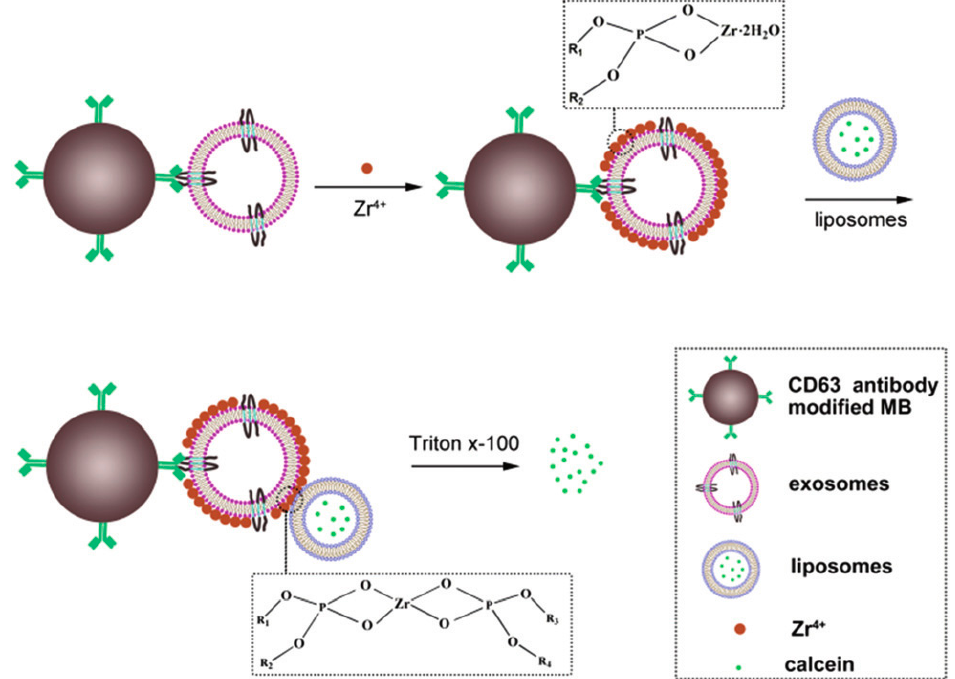
Figure 15. Schematic representation of the assay based on the aggregation of calcein-containing liposomes and exosomes bound to CD63-functionalized magnetic particles. Exosomes captured with antibody-coated magnetic beads are incubated with Zr4+ ions, which cover the surface of the vesicle. Liposomes are then able to link to the exosomes through the Zr4+ ions. The unbound liposomes are washed out and the bound ones disrupted by the detergent Triton-X-100. The released calcein dye is subsequently quantified by a spectrofluorometer. Figure reproduced from [74] with permission from The Royal Society of Chemistry.